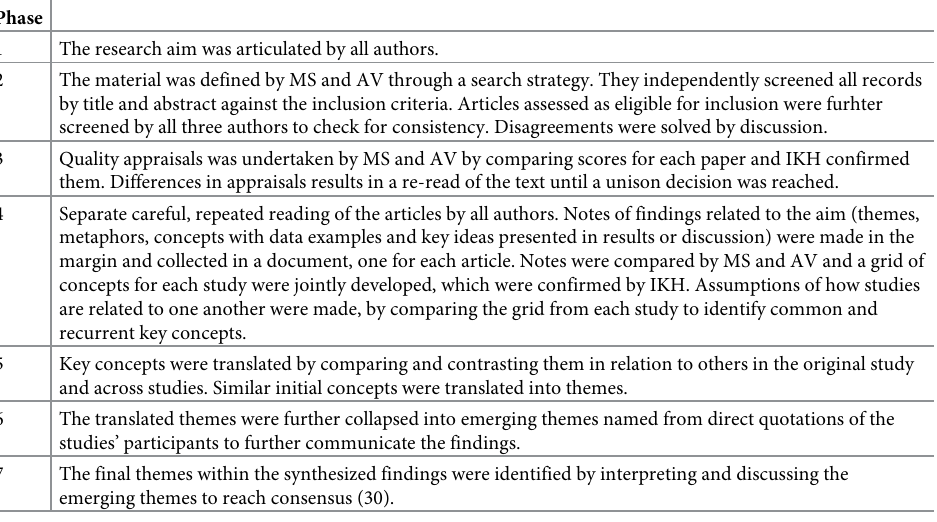
Table 1. An overview of the different phases in Noblit and Hare’s seven-phase method based on meta- etnography.